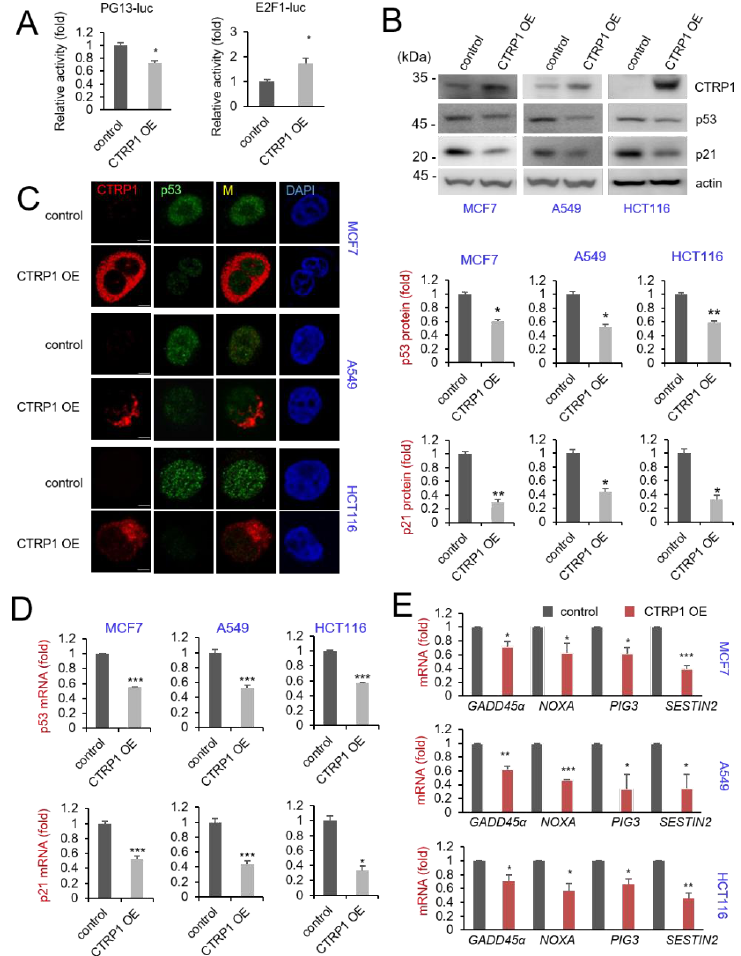
Figure 2. CTRP1 overexpression (OE) decreases p53 level and p53-dependent transcription. ( A ) Overexpression of CTRP1 decreased p53-dependent luciferase reporter activity in MCF7 cells. MCF7 cells were transfected with p53-dependent reporter (PG13-Luc) or E2F1-dependent reporter (E2F1-Luc) with either a control plasmid or the CTRP1 overexpression plasmid. Control vs CTRP1 overexpression, * p < 0.05. ( B ) Lentivirus-mediated CTRP1 overexpression decreased p53 expression. MCF7 cells, A549 cells, and HCT116(+/+) cells were infected with either control lentivirus or lentivirus encoding CTRP1. At 72 h after the infection, cells were selected by puromycin, harvested, and equal amounts of proteins from the cell lysates were probed with the indicated antibodies (upper panel). The level of p53 and p21 protein was quantified and depicted in the graph (lower panel). Control vs CTRP1 overexpression, * p < 0.05, ** p < 0.01. Images of the uncropped western blots can be found in Figure S2. ( C ) CTRP1 decreases p53. MCF7 cells, A549 cells, and HCT116(+/+) cells were infected with either control lentivirus or lentivirus encoding CTRP1, and the cells were fixed and immunostained with anti-p53 antibody (green) and anti-CTRP1 antibody (red). Scale bar, 10 μm. ( D ) CTRP1 overexpression decreased the mRNA level of p53 and p21. The level of p53 and p21 mRNA was examined by quantitative RT-PCR in control and CTRP1 overexpressed cells. * p < 0.05, *** p < 0.005. ( E ) The expression levels of GADD45α, NOXA, PIG3, and SESN2 mRNAs were measured using quantitative RT-PCR * p < 0.05, ** p < 0.01, *** p < 0.005. We further tested this hypothesis by overexpressing CTRP1 in Caco2 cells, a p53 null cell line. Western blotting showed that the p53-dependent transcription of p21 did not decrease in this case (Figure 3A). Next, we examined the mRNA expression levels of p53 Next, we examined whether CTRP1 expression decreased p53 protein levels and p53-dependent transcription. Western blot analysis showed that the expression levels of p53 protein and p21 protein, a well-known transcriptional target of p53, were significantly reduced in CTRP1 overexpressed cancer cell lines MCF7, A549, and HCT116 (Figure 2B). Confocal microscopy confirmed that the overexpression of CTRP1 downregulated